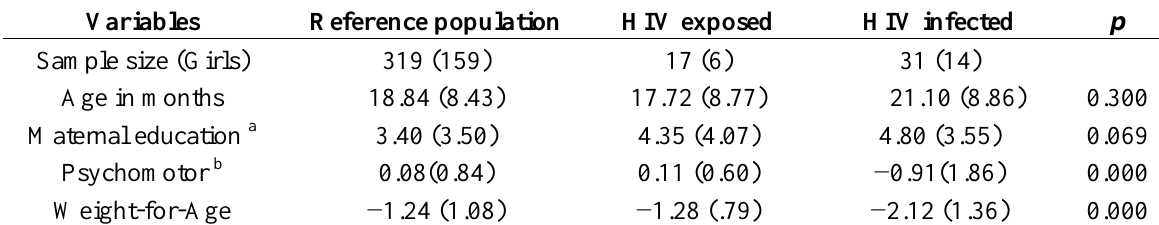
Table 1. Means (and standard deviations) of the various background